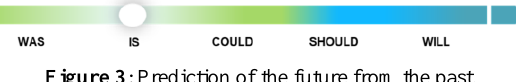
Figure 3 : Prediction of the future from the